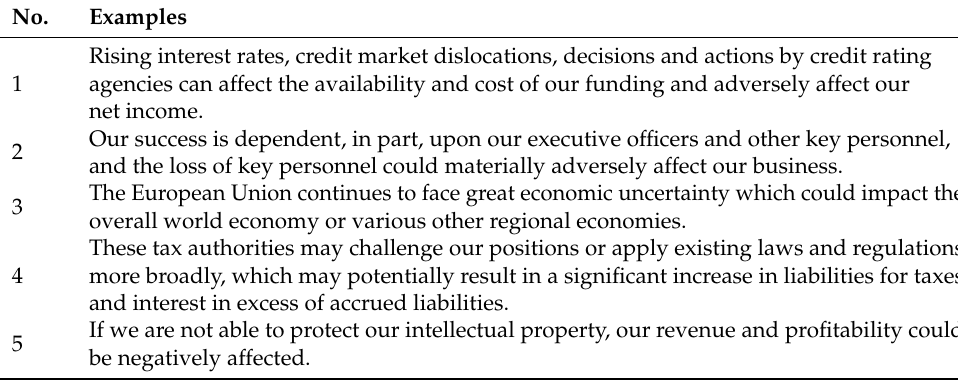
Table 1. The examples of risk disclosure sentences in Form